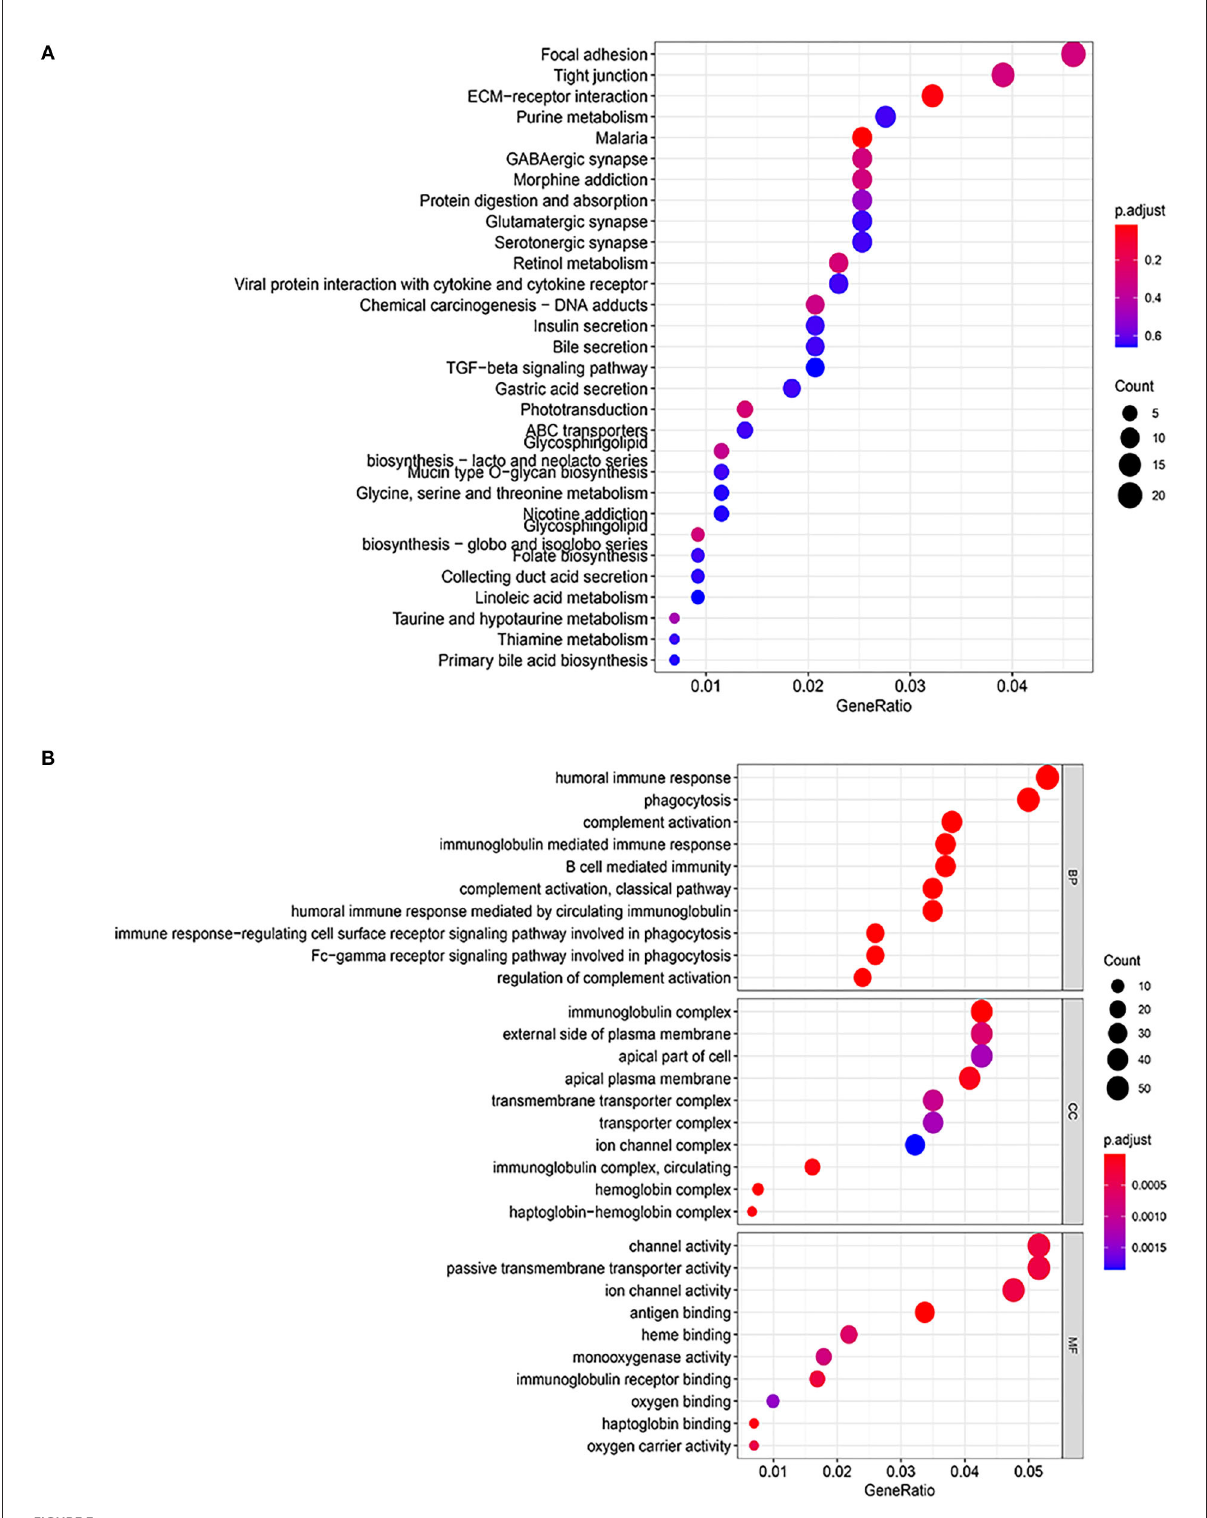
FIGURE3 GO and KEGG pathway enrichment analysis of all DEGs of PCHD. (A) Bubble chart shows KEGG pathway enrichment significance items of DEGs. (B) Bubble chart shows GO pathway enrichment significance items of DEGs in three functional sections: biological processes (BP), cell composition (CC), and molecular function (MF). The Y-axis label represents enrichment significance terms and the X-axis label represents the gene